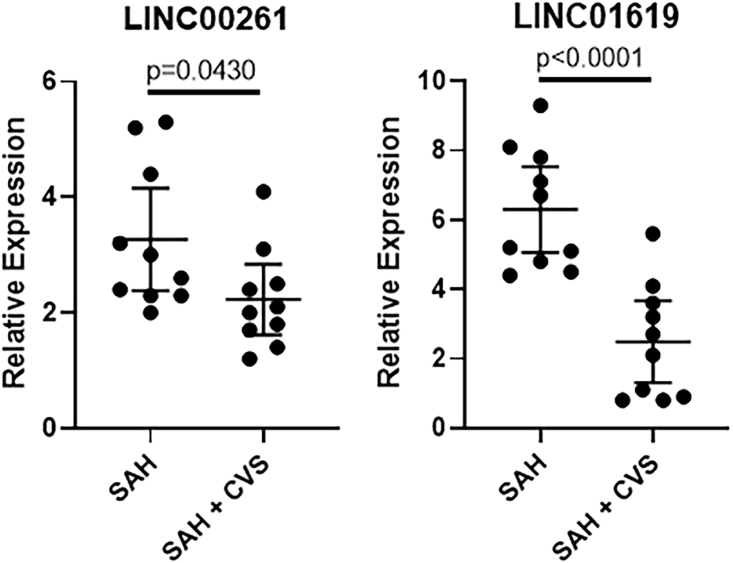
lncRNAs LINC00261 and LINC01619 in SAH PatientsExpression levels of lncRNAs LINC00261 and LINC01619 in pooled samples representing patients with SAH (without CVS) and those with SAH and CVS. Values plotted are mean ± 95% CI.